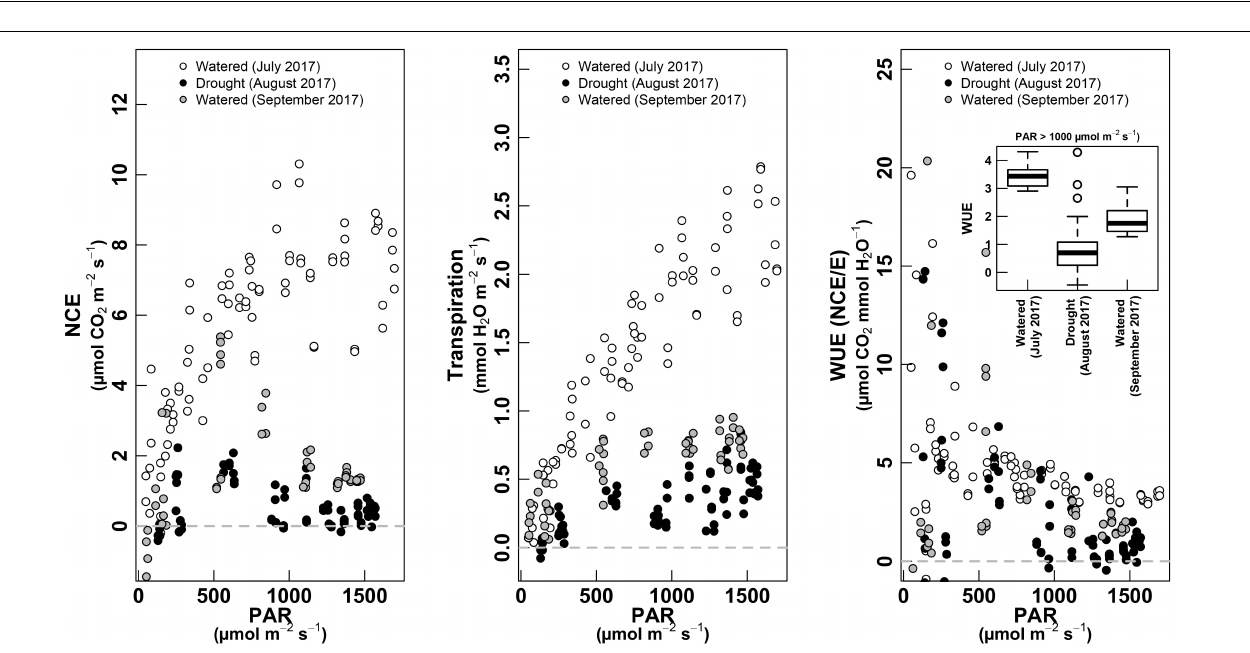
FIGURE 5 | Daily cycle of NCE—whole-plant net carbon exchange (left panel, µ mol m − 2 s − 1 ) and whole-plant Transpiration (right, mmol m − 2 s − 1 ), for three water treatments: white dots for “Watered” (measured in July 2017); black dots for “Drought” (measured in August 2017); gray dots for “Watered” (measured in September 2017). The white triangles are measurements performed in 2015 (Pou et al., 2014, unpublished), using the same chamber and experimental set-up in watered conditions.